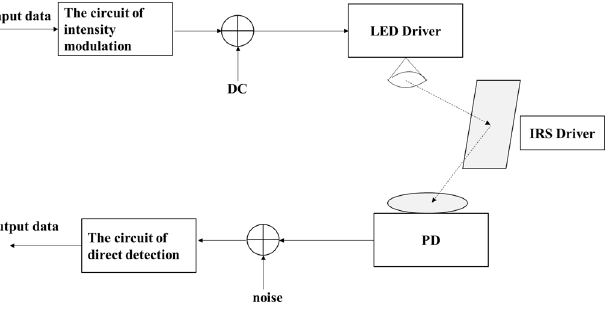
Figure 3. The total power consumption model in the VLC system via mirror array-based